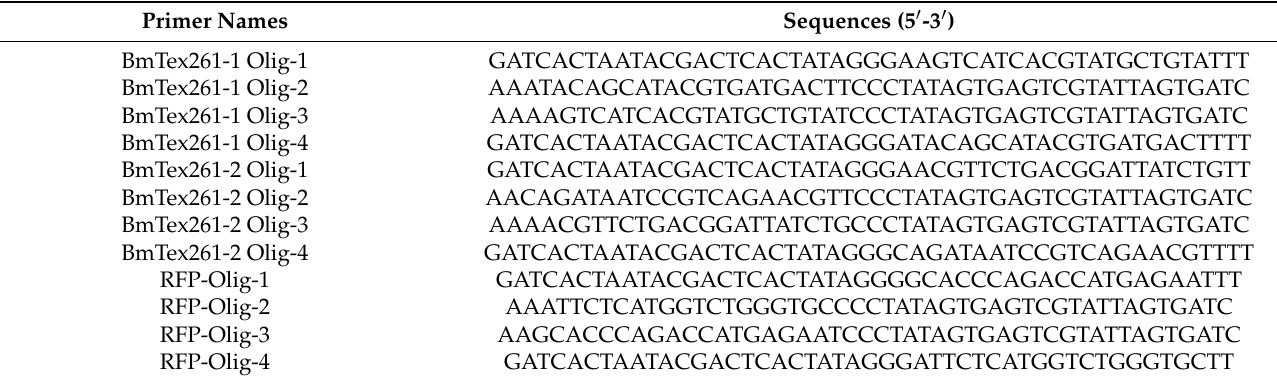
Table 2. List of primer sequences used to synthesise